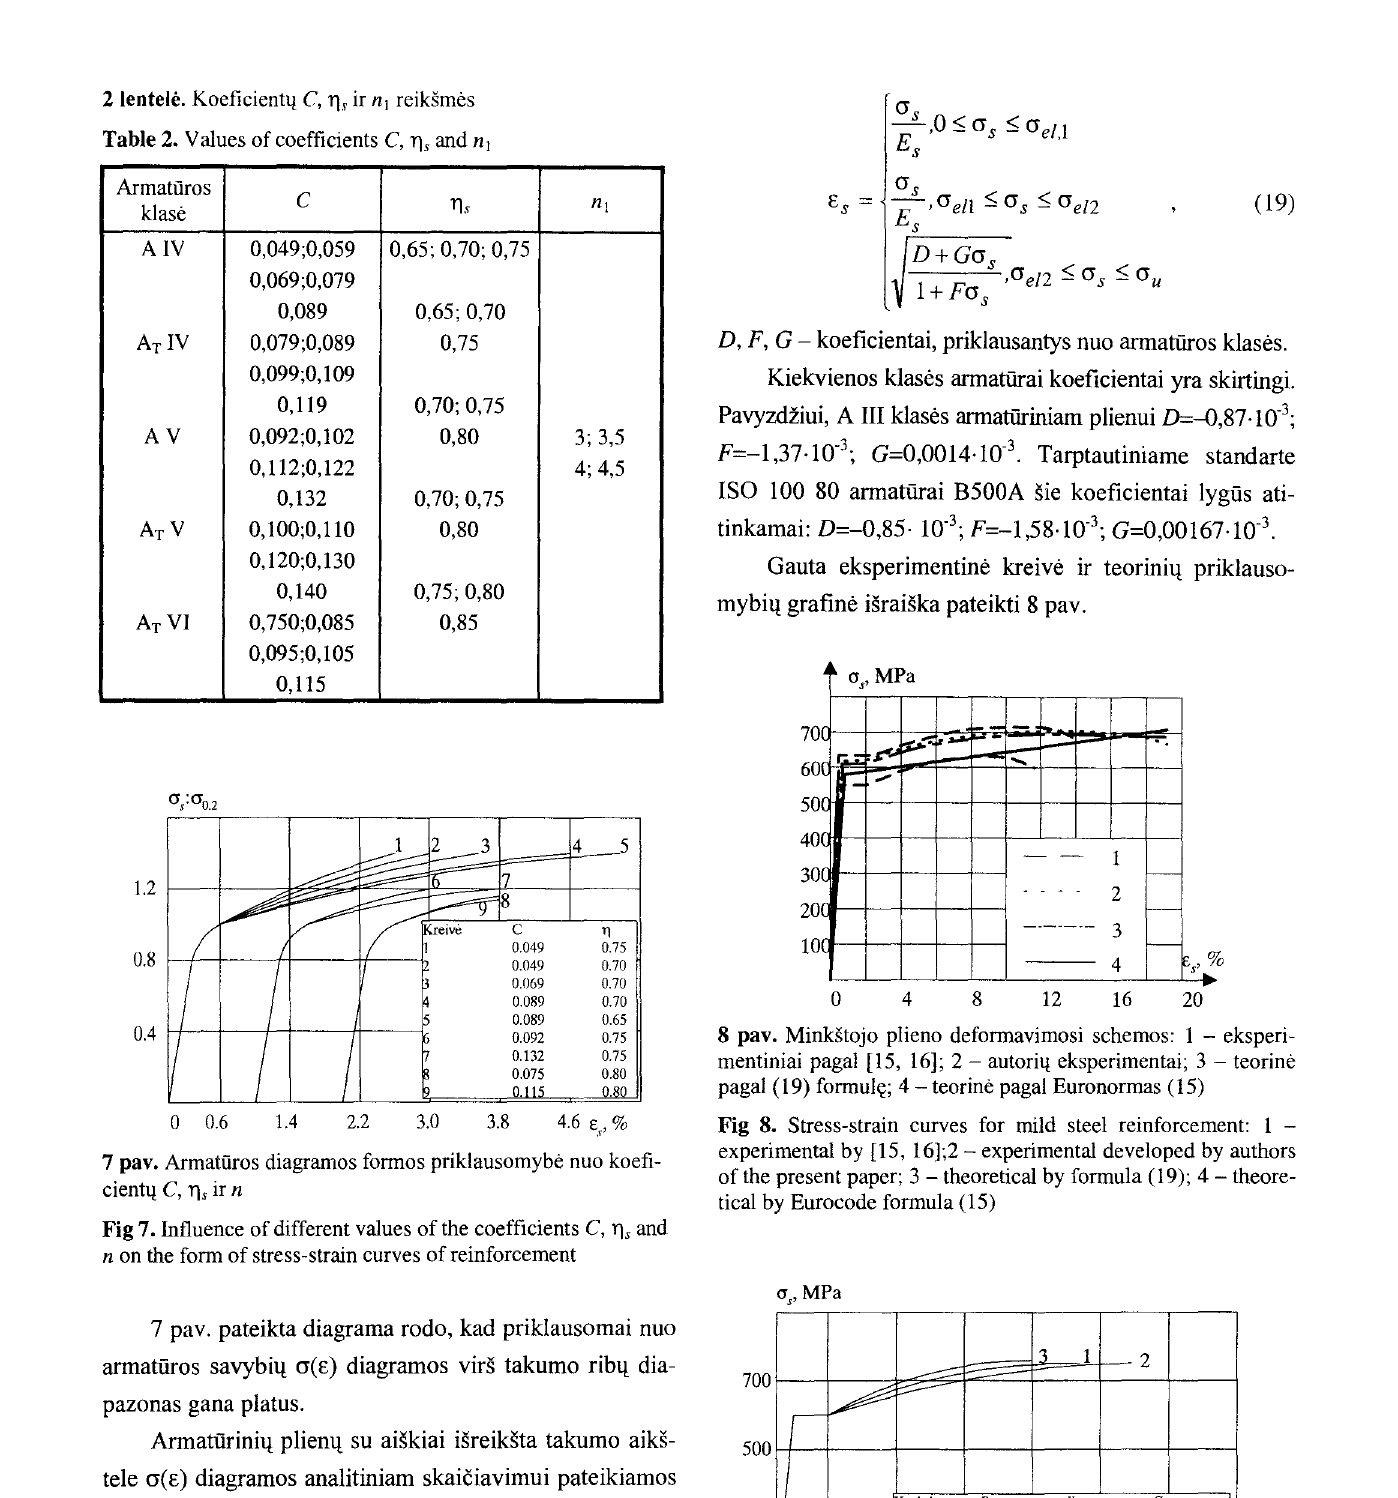
Table 2. Values of coefficients C, Yls and n